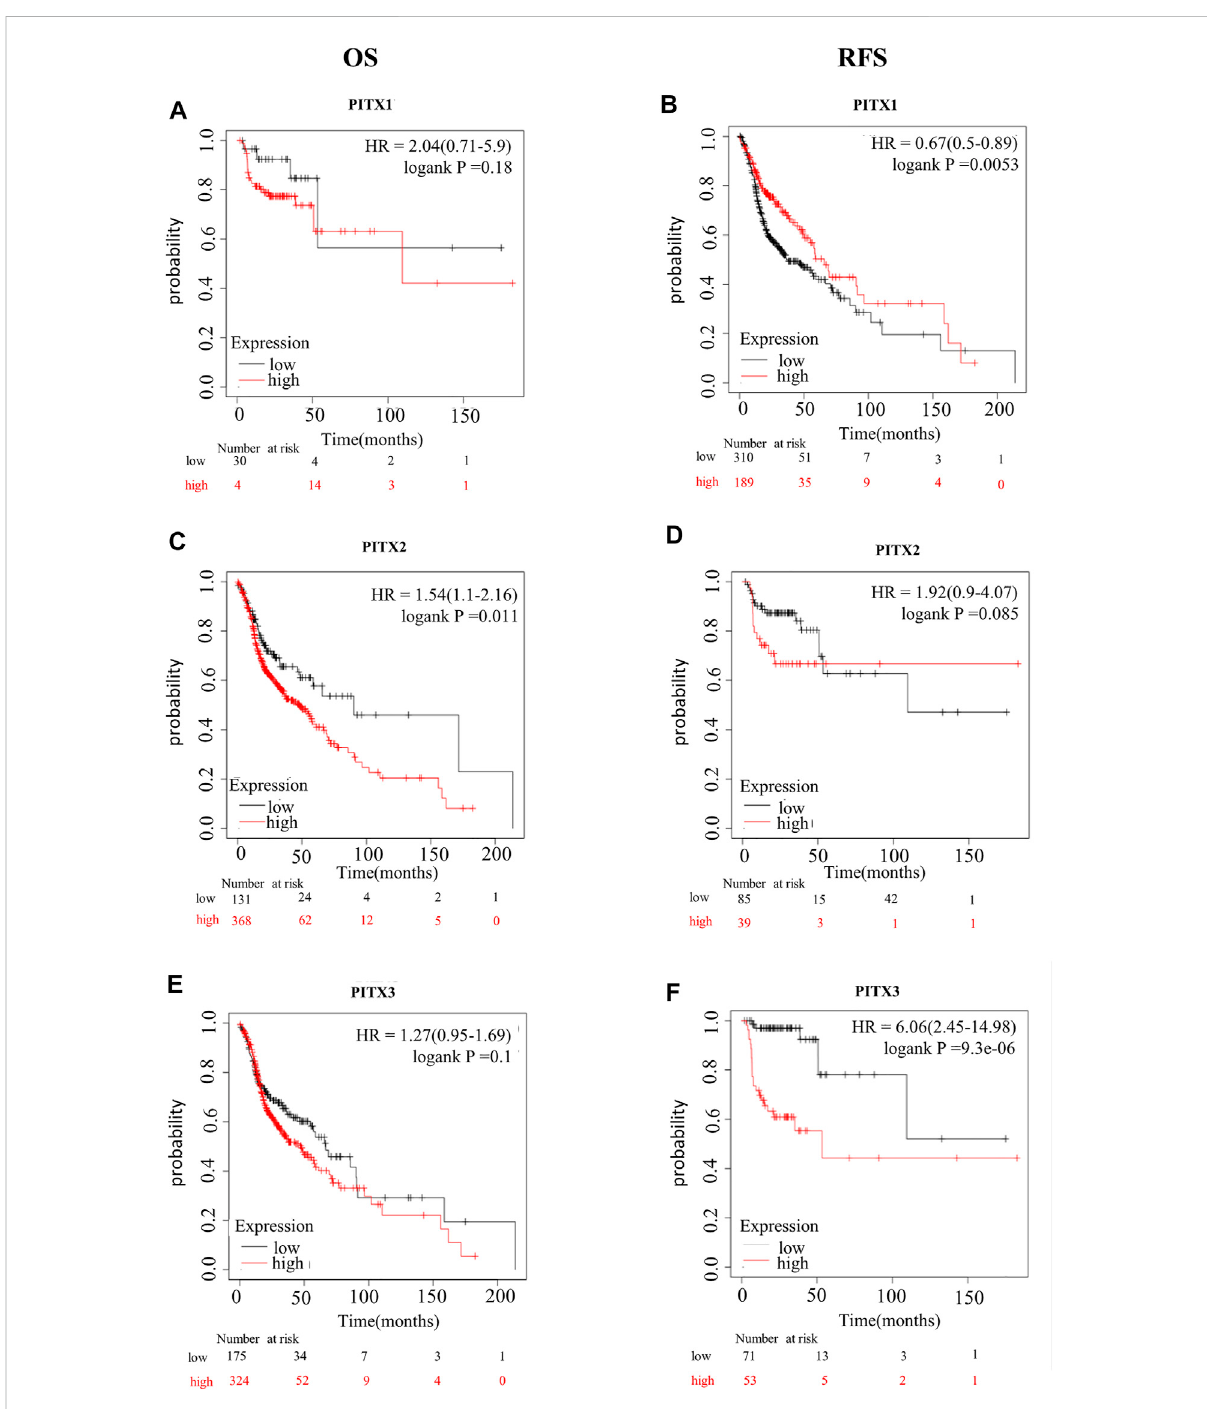
FIGURE 3 Kaplan-MeiersurvivalcurvesforHNSCprognosticPITXgenes.Kaplan-Meiersurvivalcurvesfor PITX1 showing (A) OSand (B) RFS;Kaplan-Meier survival curves for PITX2 showing (C) OS and (D) RFS; Kaplan-Meier survival curves for PITX3 showing (E) OS and (F)